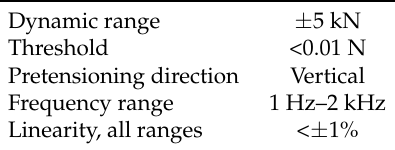
Figure 7. Scheme of the setup ( top ) and image of the sensors and the piece being machined ( bottom ). Table 2. Main characteristics of the dynamometer Kistler